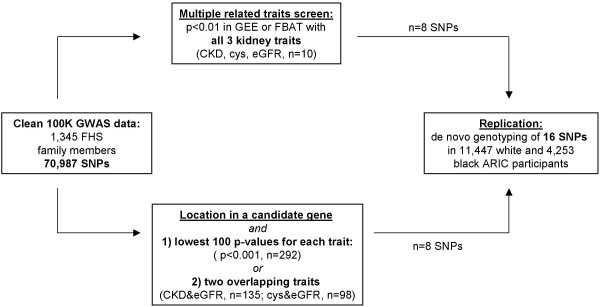
Selection process of SNPs from the FHS 100 K GWAS screen to be followed up by genotyping in the ARIC cohort. Abbreviations: GWAS: genome-wide association, SNPs: single nucleotide polymorphisms, GEE: generalized estimating equation, FBAT: family-based association test, CKD: chronic kidney disease, eGFR: estimated glomerular filtration rate, cys: cystatin C.